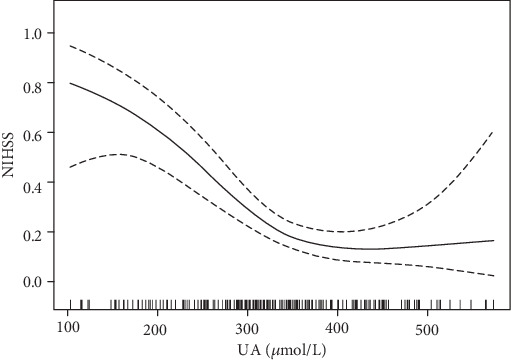
Relationship between UA (μmol/L) and NIHSS. The middle line represents a smooth curve fit between the variables. The curves on both sides represent the 95% confidence interval for the fit. The model was adjusted according to sex, age, systolic BP, diastolic BP, hypertension, diabetes, coronary artery disease, smoking, drinking, total cholesterol, triglyceride, HDL cholesterol, LDL cholesterol, homocysteine, creatinine, and urea nitrogen.